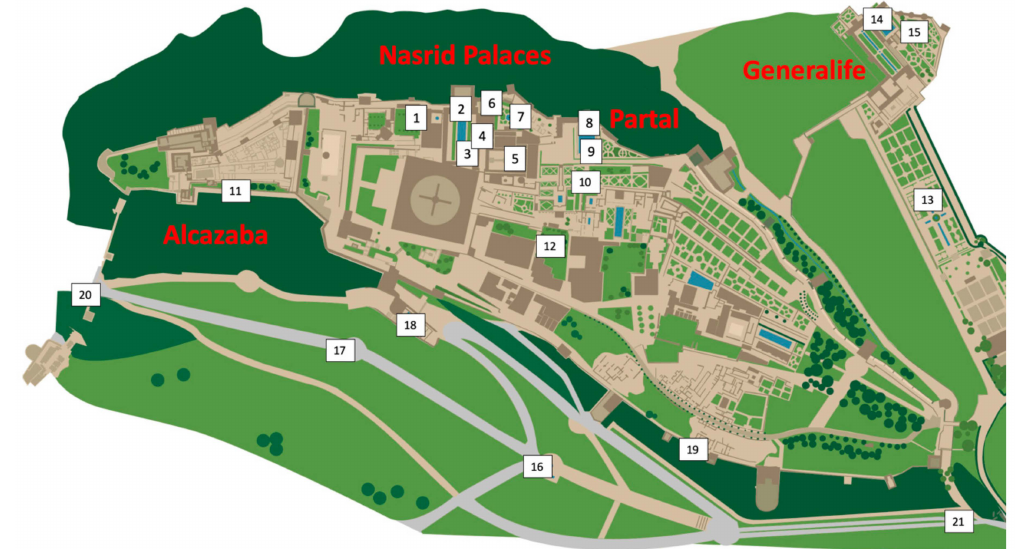
Figure 3. Sampling points in the monumental complex of the Alhambra and the Generalife. The labels correspond to Table